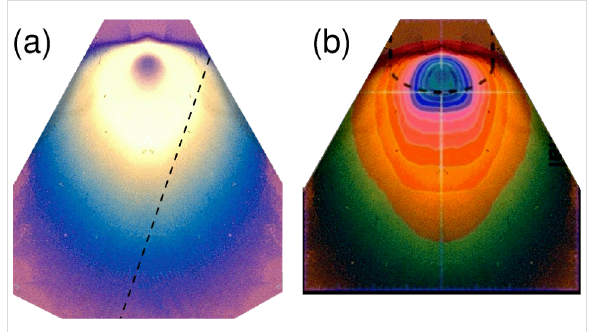
Figure 1: (a) Optical micrograph of the Co dissociation product on the plasma-activated silica surface. The deposit mimics the flux profile set by the gas injection needle. The dashed line represents the rightmost substrate edge. The deposit profile to the right of the dashed line was complemented by image processing from the left side for ease of com- parison. (b) Overlay of the calculated precursor flux profile from [34] (contour lines) with the isotropically scaled optical microsocope image of the deposit profile shown in